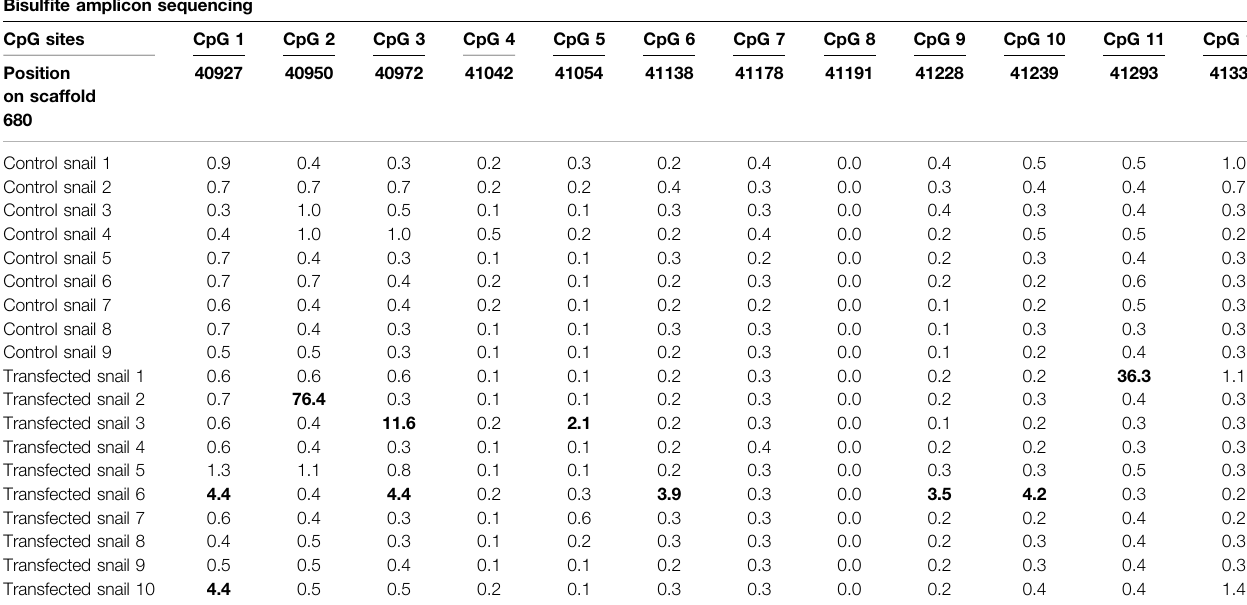
TABLE 6 | CpG methylation results from bisul fi te amplicon sequencing CpG sites of the targeted gene BGLB032652 found in the genomic region: LGUN_random_Scaffold680: 40,914-41,372. Bisul fi te amplicon sequencing CpG sites Position on